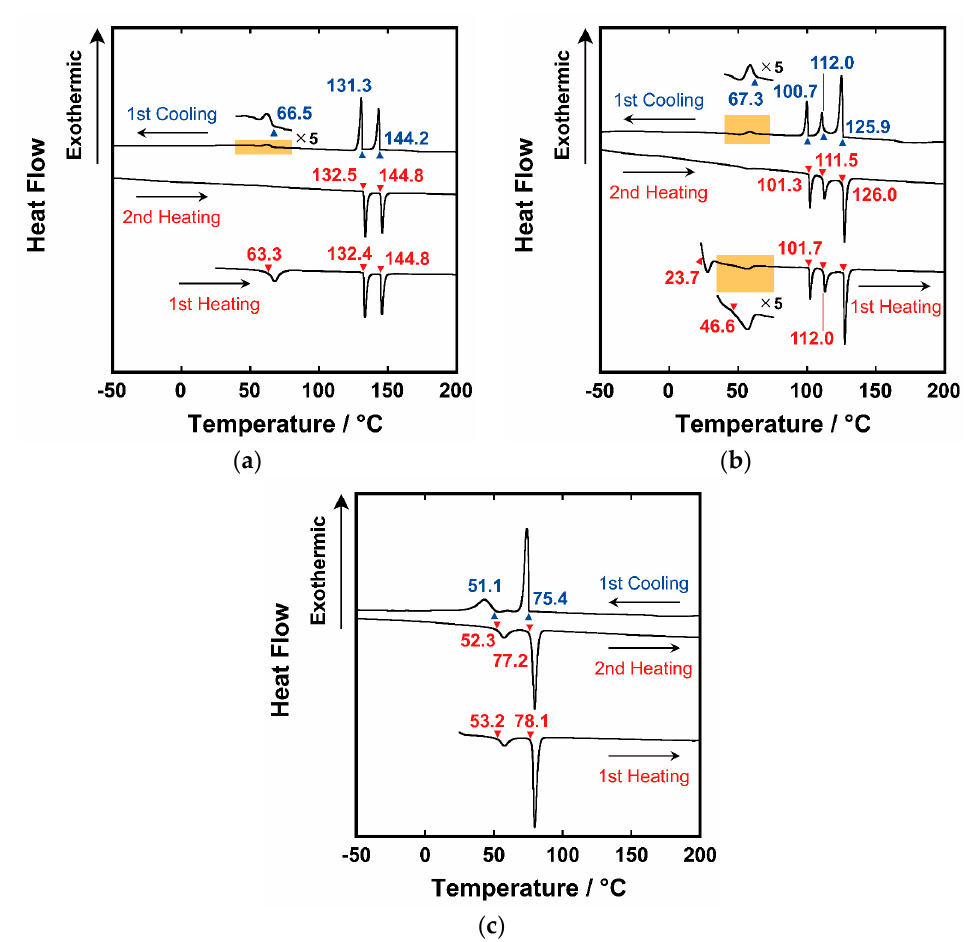
Figure 5. DSC thermograms of ( a ) ( R )- 1 , ( b ) ( R )- 2 , and ( c ) ( R )- 3 at a scanning rate of 10 °C min − 1 .